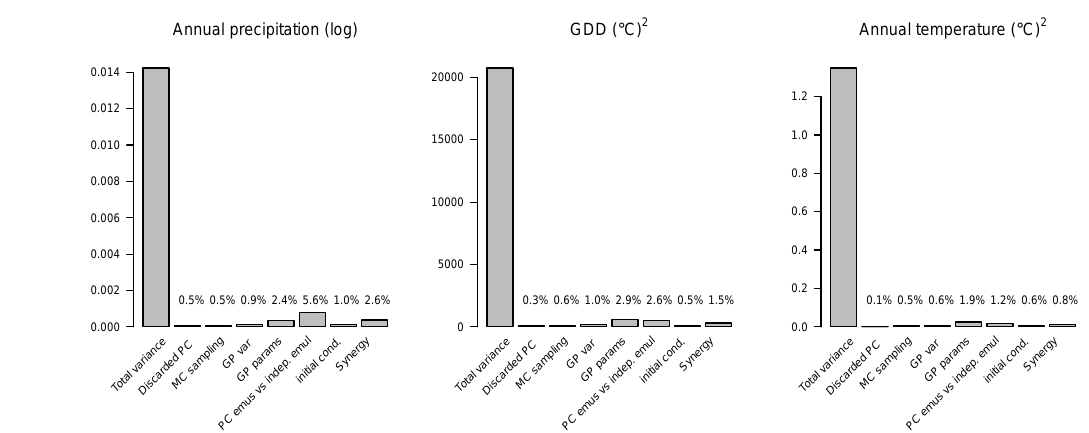
Figure 6. Total variances associated with inputs considered grid-point-wise, and then averaged over all grid points. These variances are then compared to different elements of variances associated with the PC emulator, namely variance in the discarded principal components, error estimated from Monte Carlo sampling (estimated by comparison with analytical integrals), Gaussian process variance ( (cid:54) tot ), difference in variance associated with the choice of correlation parameters (constant for all PC, or PC-dependent), or the choice of emulator (PC emulator vs. independent emulators), difference due to the choice of initial conditions (experiment 20 excluded), and synergy term defined as V − T { e(cid:36) } − T ε .